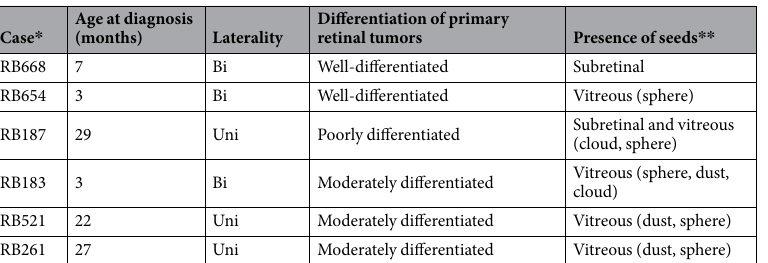
Table 1. Case characteristics and features of retinal tumors and seeds in enucleated globes. * All eyes are classified into group E according to International Classification of Retinoblastoma; all cases undergo